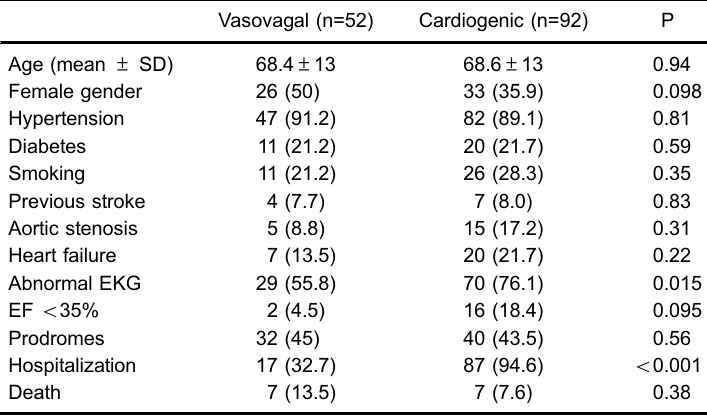
Table 1. Baseline characteristics for the two types of syncope.